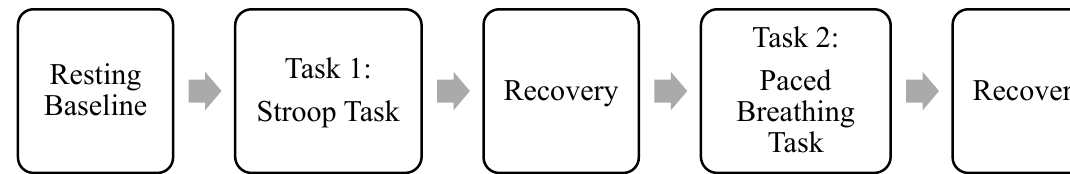
Figure 1. Overview of Study Procedures for Group 1.